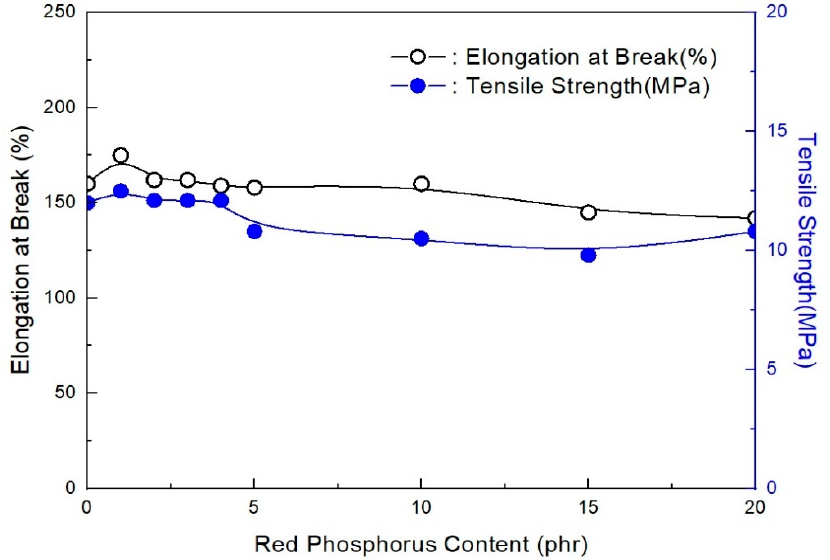
Figure 1. Mechanical properties of EVA/LLDPE 118W/120 phr flame-retardant (MH + RP) formula- tions as a function of RP content.